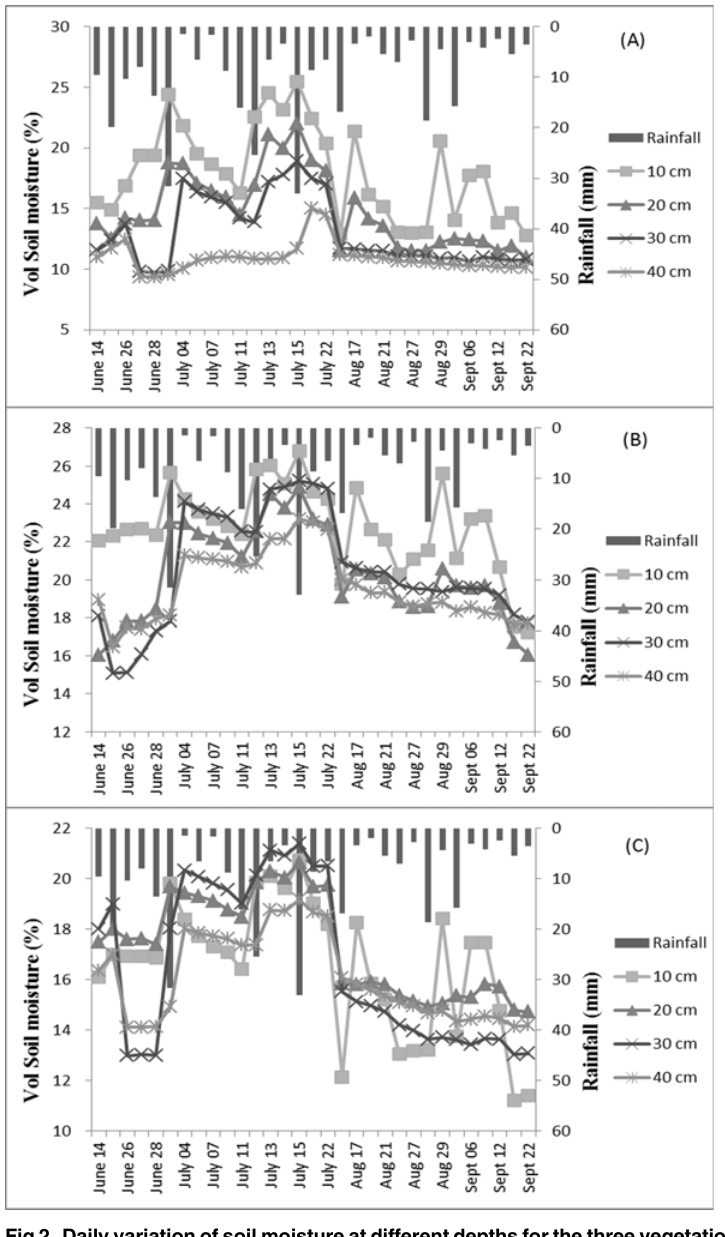
Fig 2. Daily variation of soil moisture at different depths for the three vegetation types. (A) Soil- moisture content of AL, (B) soil-moisture content of QM, and (C) soil-moisture content of UG. Notes: AL, artificial Larix spp.; QM, Quercus mongolica ; UG, unused grassland.